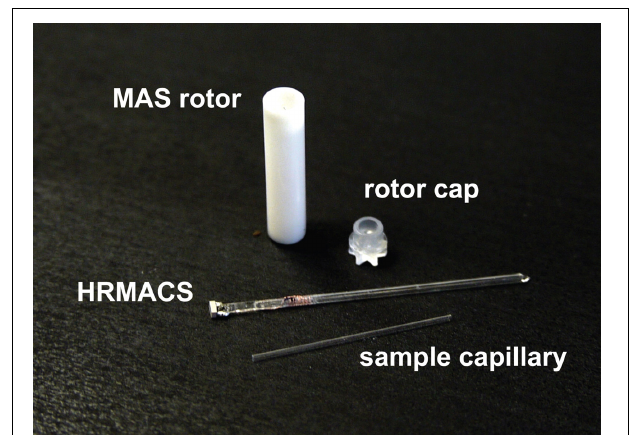
FIGURE 1 | A photo-illustration of the sample-exchange HR-MACS setup used in this study.